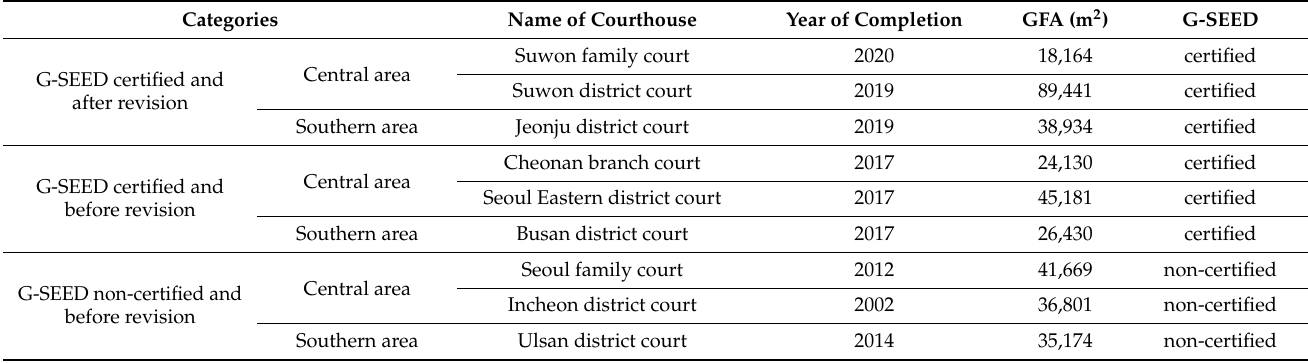
Table 3. Collected data information.